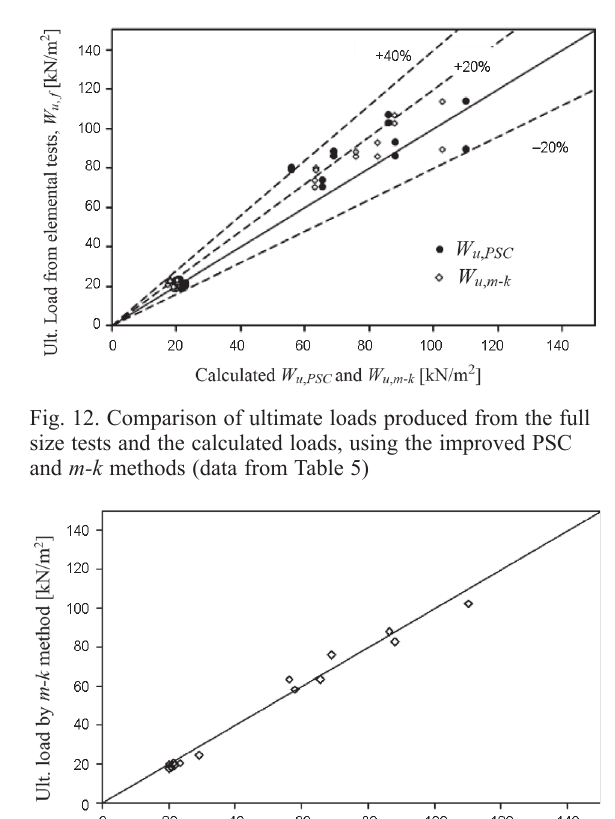
11. Comparison of ultimate loads produced from the elemental tests and the calculated loads, using the improved PSC and m-k methods (data from Table 5)